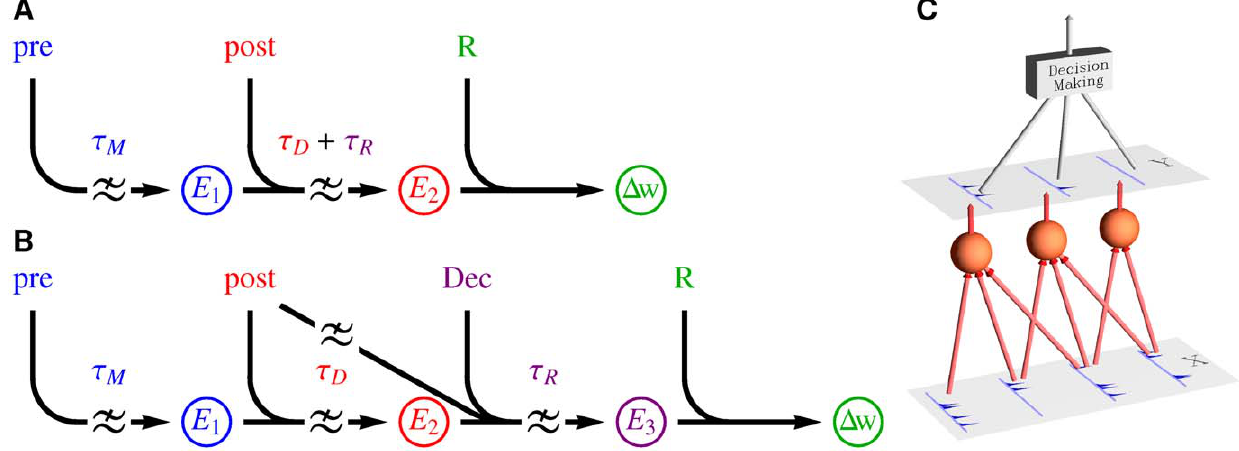
Figure 1. Plasticity cascades and decision making. (A) Synaptic plasticity cascades for reinforcement learning in the single neuron approach and (B) in the proposed population level approach. The meaning of the symbols is the following. E i : synaptic eligibility traces, D w : change in